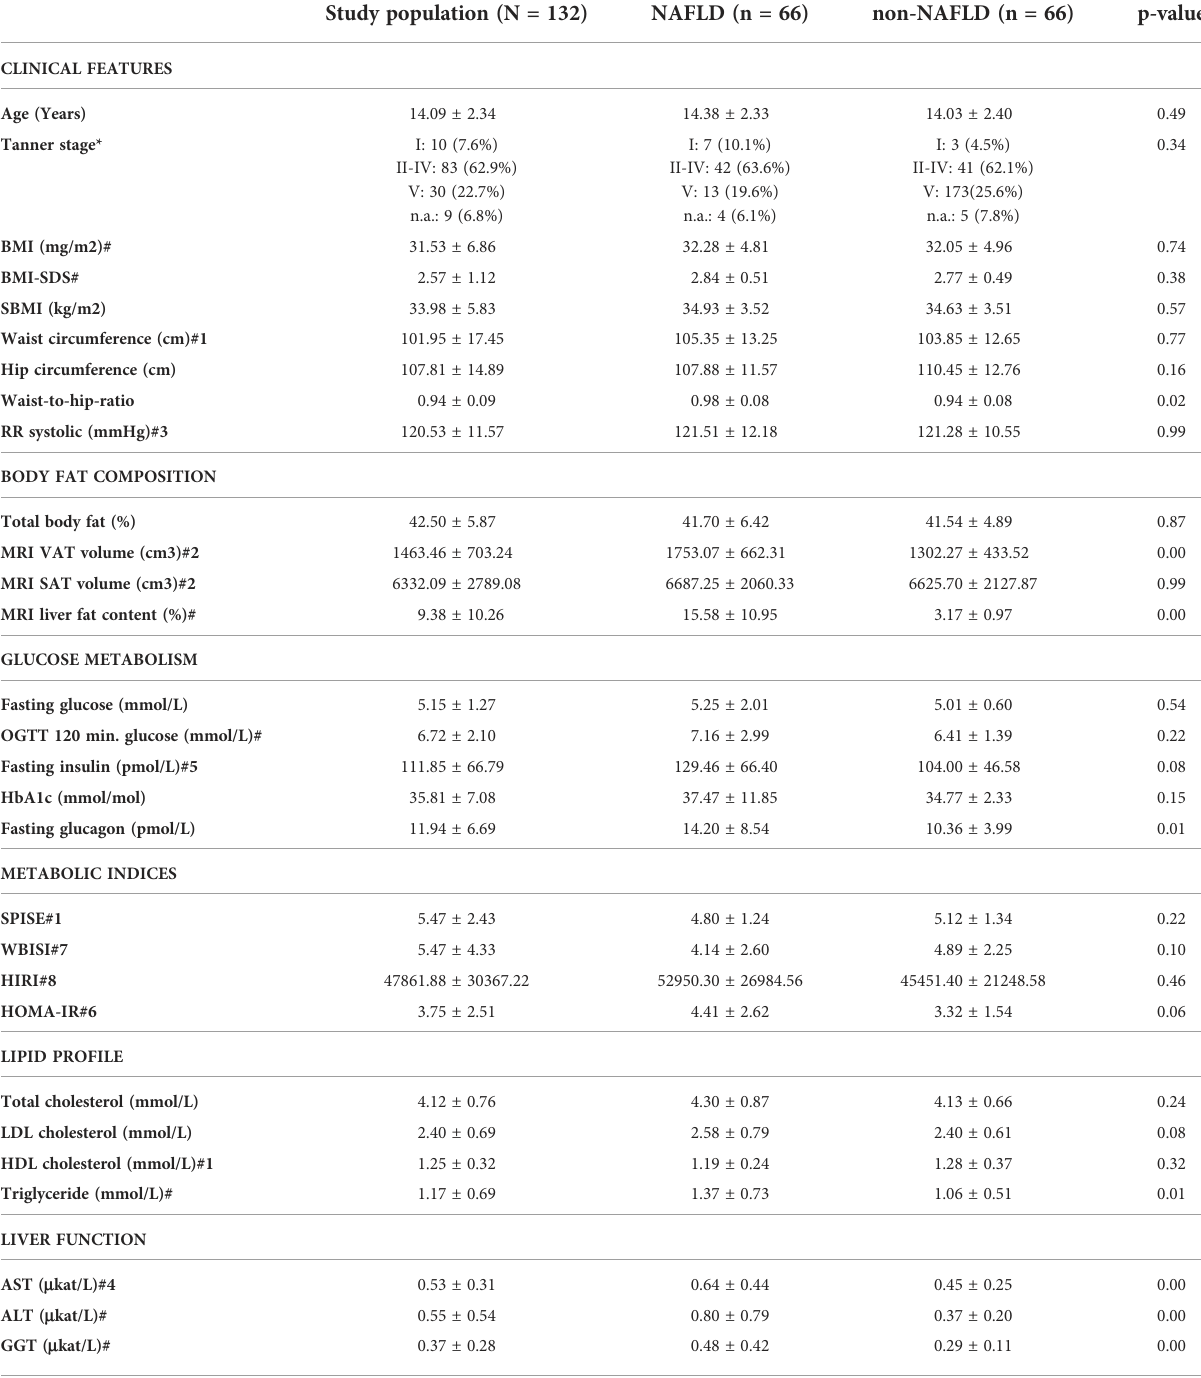
TABLE 1 Descriptive data of all patient (study population, N = 132) and comparison of baseline characteristic difference between NAFLD (n = 66) and non- NAFLD (n = 66)